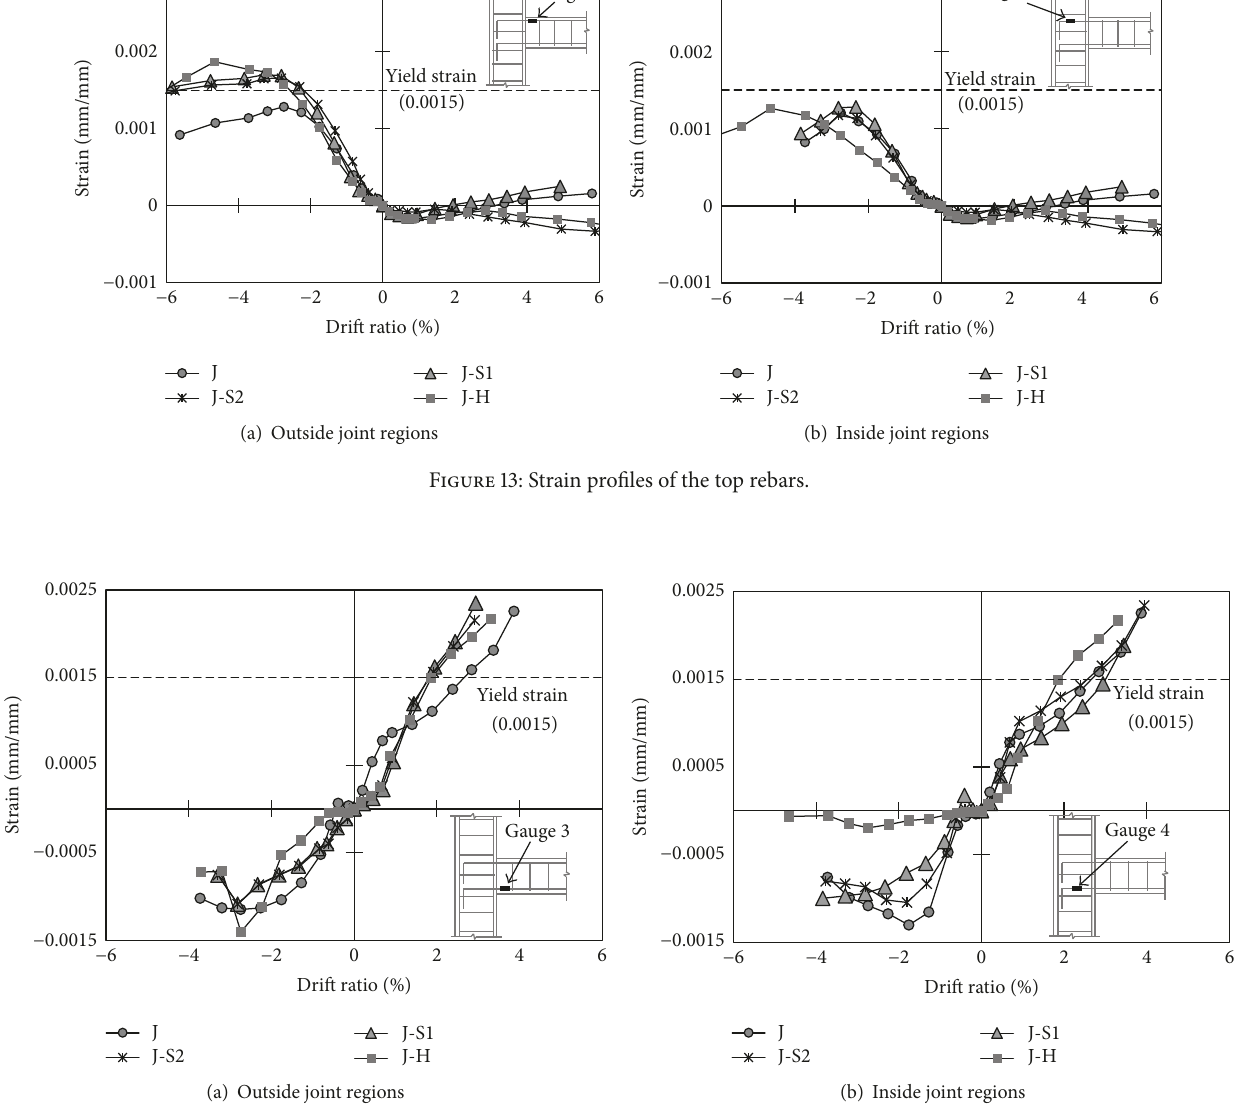
Figure 14: Strain profiles of the bottom